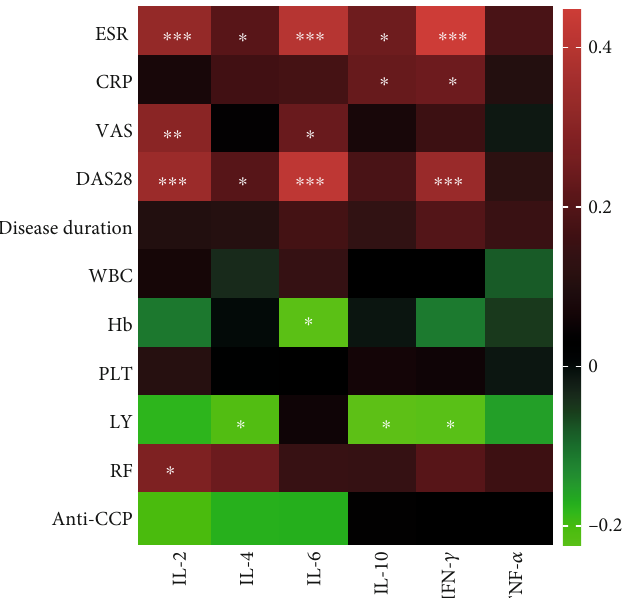
Figure 4: Heatmap of correlation of the serum cytokine levels of IL-2, IL-4, IL-6, IL-10, INF- γ , TNF- α with ESR, CRP, VAS, DAS28, disease duration, WBC, Hb, PLT, LY, RF, and anti-CCP in RA patients. ( ∗ p < 0 : 05 , ∗∗ p < 0 : 01 , and ∗∗∗ p < 0 : 001 by Spearman ’ s correlation